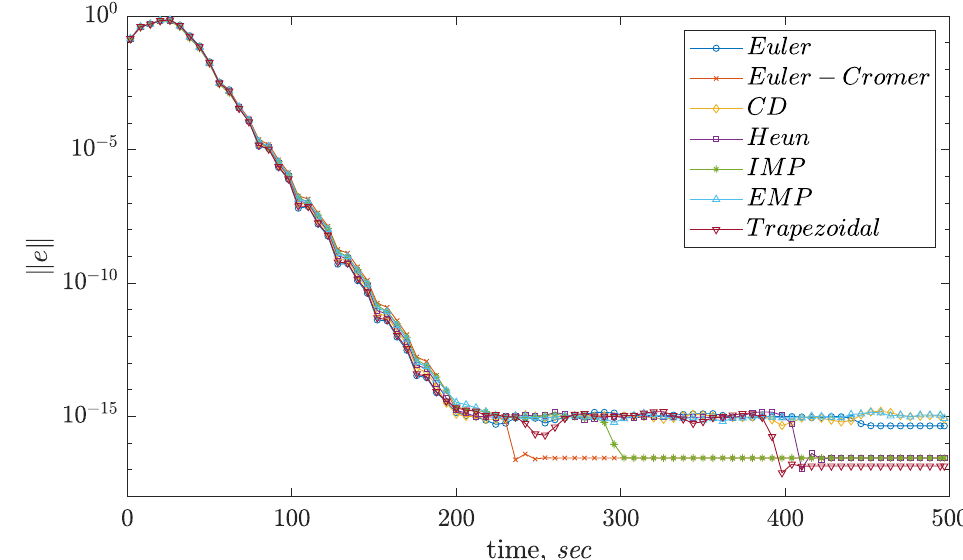
Figure 5. Synchronization error between slave systems for different integration methods, smoothed with a median filter; the window size is 600